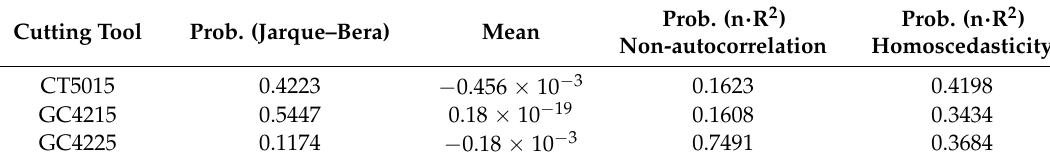
Table 7. Results of the basic assumptions of regression analysis.